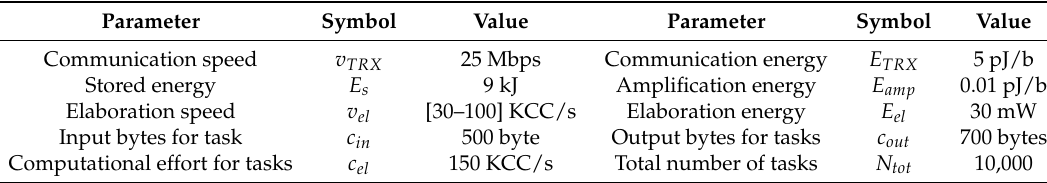
Table 1. List of network parameters. KCC, Kilo Clock